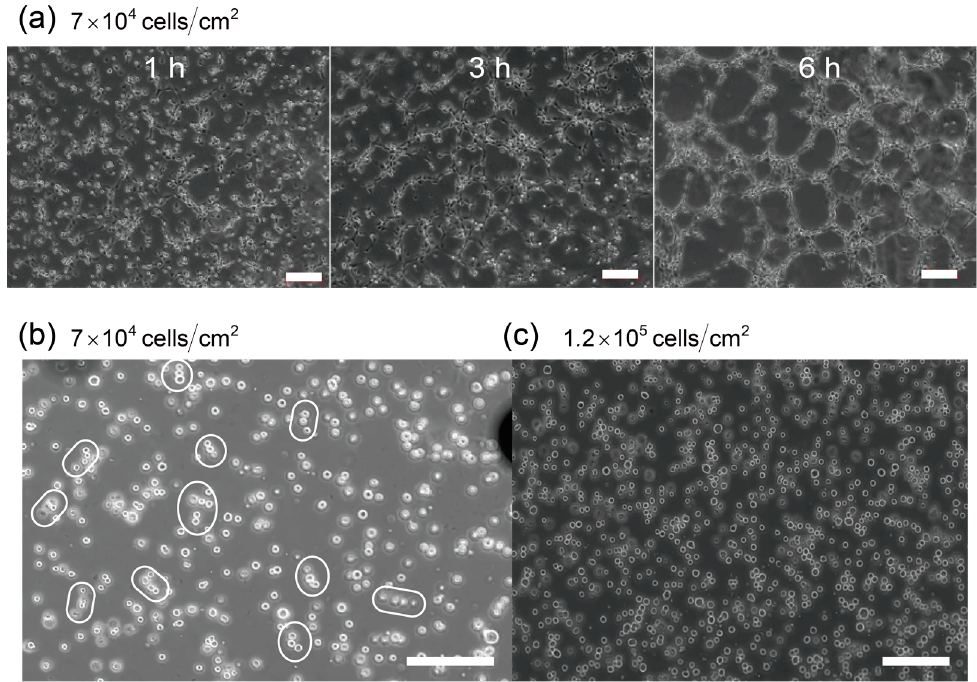
Figure 1. ( a ) Network formation of vascular endothelial cells at 6 h after dispersion of cells. When the areal fraction of cells was sufficiently high to distribute throughout the system (above the percolation threshold [8]), the cells first shrunk and then formed networks; ( b ) As a primary phenomenon of network formation, chain-type clusters were formed before cells adhered to the substrate. When the number of these increased, the chains formed percolated networks, as shown in ( a ); ( c ) In the case of increased cell density, cells still tended to form chains, and the coarsening seems to be stopping for a while. These photos are taken by Matsunaga [14]. Both of the photos, ( b , c ), are taken at 10 min after cells were dispersed into the medium. All of the experiments above were conducted with the culture in the absence of VEGF (vascular endothelial growth factor). All scale bars indicate 200 μ m.